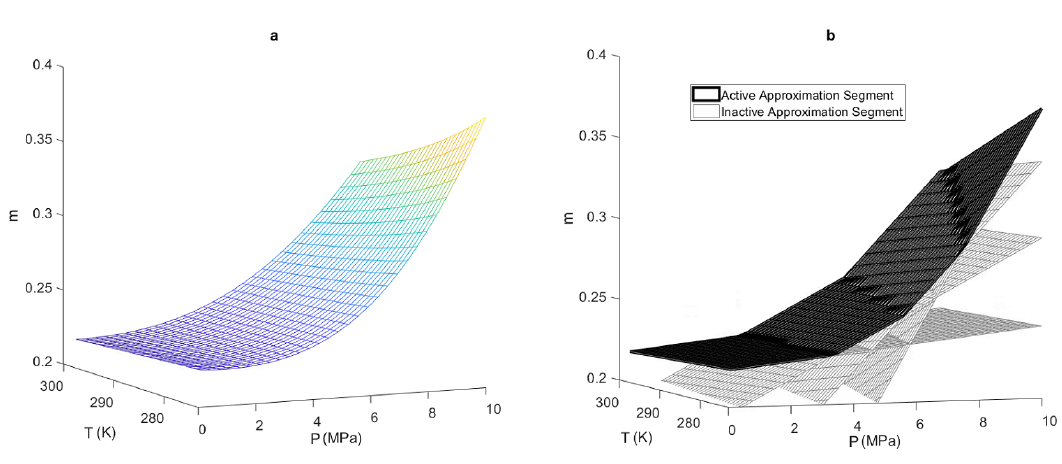
Figure 10. ( a ) Rigorous three-dimensional relationship between m and temperature–pressure; and ( b ) piecewise- linear approximation of m using four planes for natural gas with a composition of: 85% methane, 14% ethane, and 1%